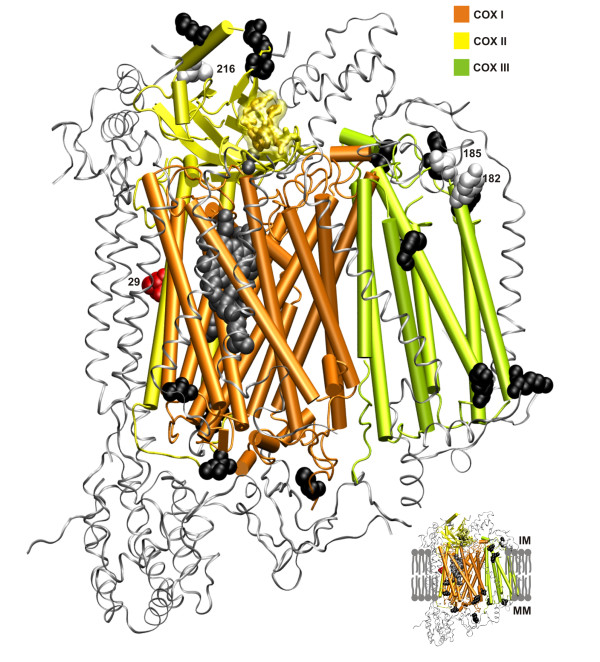
Three-dimensional representation of variable amino acid in mammalian cytochrome c oxidase subunits I, II and III. Sites within COX subunits showing a high number of amino acid properties positive selected [see Additional file 1, Fig. S4] mapped into the bovine structure (pdb code: 1V54 [67]). Side-chains with over 5 amino acid properties positive selected are presented as black spheres. Sites showing particular mutational trends are shown in white (see text for further details). Mutations in sites shown in red have been related to exercise intolerance in humans (see Table 1). Prosthetic groups are presented as grey spheres. The side chains of the hydrophobic loop in COXII that is involved in cytochrome c docking and electron transfer are depicted as sticks together with their van der Waals surface. The nuclear encoded subunits of Complex IV are shown as in silver. MM: mitochondria matrix; IM: intermembrane space.